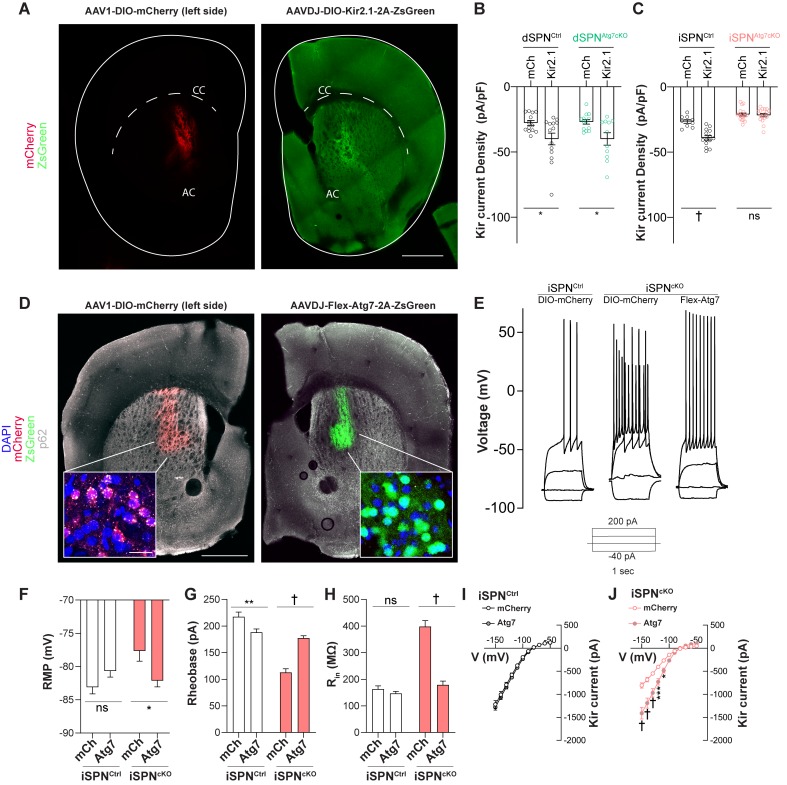
Atg7 reexpression but not Kir2.1 overexpression rescues changes in iSPN physiology.(A) Immunofluorescent images of striatal hemisections from mice injected with AAV1-DIO-mCherry or AAVDJ-DIO-Kir2.1-t2A-zsGreen stained against mCherry (left) or GFP (right). Scale bar 500 µm. (B) Significant effect of Kir2.1 overexpression on Kir2 current density in dSPNs from control and dSPNs from dSPNAtg7cKO mice. Data analyzed with two-way ANOVA. Genotype x virus: F(1,47)=0.01278, p = 0.9105; Genotype: F(1,47)=0.01840, p = 0.8937; Virus: F(1,47) = 13.23, p=0.0007. N = dSPNCtrl (D1cre Atg7wt/wt, mCh: n = 13(4), Kir2.1: n = 14(4)) or dSPNAtg7cKO (D1cre Atg7Fl/Fl, mCh: n = 13(4), Kir2.1: n = 11 (3)). (C) Significant effect of Kir2.1 overexpression on Kir2 current density in iSPNs from control but not from iSPNAtg7cKO mice. Data analyzed with two-way ANOVA. Genotype x virus: F(1,54) = 17.62, p = 0.0001. N = iSPNCtrl (A2Acre Atg7wt/wt, mCh: n = 9 (3), Kir2.1: n = 14(3)) or iSPNAtg7cKO (A2Acre Atg7Fl/Fl, mCh: n = 18(5), Kir2.1: n = 17(4)). (D) Representative hemisections from iSPNAtg7cKO mice injected with AAV1-DIO-mCherry (left) or AAVDJ-Flex-Atg7-2A-ZsGreen (right) showing reduction in p62 puncta in cells expressing Atg7 (right) compared to mCherry (left). Scale Bar 500 µm. Inset, scale bar 20 µm. (E) Representative current clamp traces from mCherry-expressing iSPN in a control (A2Acre) mouse, mCherry expressing iSPN in an iSPNAtg7cKO mouse or an Atg7-expressing iSPN from an iSPNAtg7cKO mouse. (F-J) Reexpression of Atg7 normalizes RMP [N = iSPNCtrl: mCh: n = 25(5), Kir2.1: n = 26(5)) or iSPNAtg7cKO: mCh: n = 13(3), Kir2.1: n = 15(3). Genotype x virus: F(1,76)=9.491, p = 0.0029], rheobase [N = iSPNCtrl: mCh: n = 25(5), Kir2.1: n = 26(5)) or iSPNAtg7cKO: mCh: n = 14(3), Kir2.1: n = 15(3). Genotype x virus: F(1,75)=36.54, p<0.0001], Rin [N = iSPNCtrl: mCh: n = 25(5), Kir2.1: n = 26(5)) or iSPNAtg7cKO: mCh: n = 13(3), Kir2.1: n = 16(3). Genotype x virus: F(1,76)=55.55, p<0.0001], and Kir2 current in iSPNs from iSPNAtg7cKO mice compared to mCherry control but only reduces Rin in controls. All data analyzed by two-way ANOVA. In (I), N = iSPNCtrl: mCh: n = 9 (5), Kir2.1: n = 9 (5). Voltage x virus: F(10,160)=0.1170, p = 0.9996; Voltage: F(10,160) = 178.8, p<0.0001; Virus: F(1,16)=0, p = 0.9929. In (J), N = iSPNAtg7cKO: mCh: n = 10(3), Kir2.1: n = 12(3). Genotype x virus: F(10,200) = 18.56, p<0.0001. ns p>0.05, *p<0.05, **p<0.01, ***p<0.001, † p<0.0001.